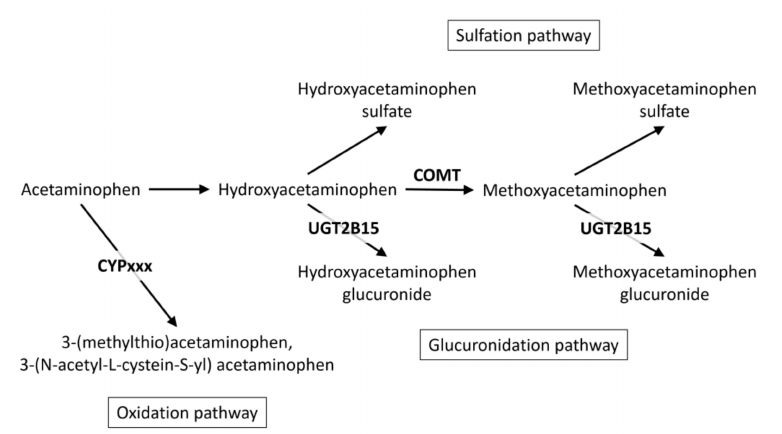
Figure 4. Schematic view of acetaminophen metabolism, showing metabolites and genes that were linked in this